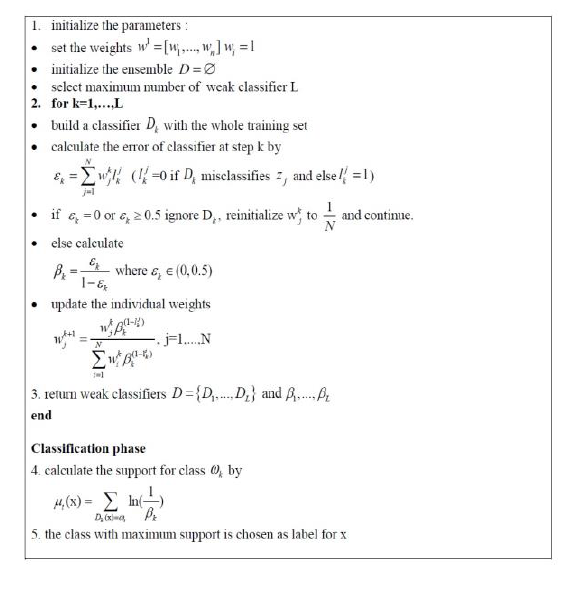
Fig.1: AdaBoost.M1 algorithm